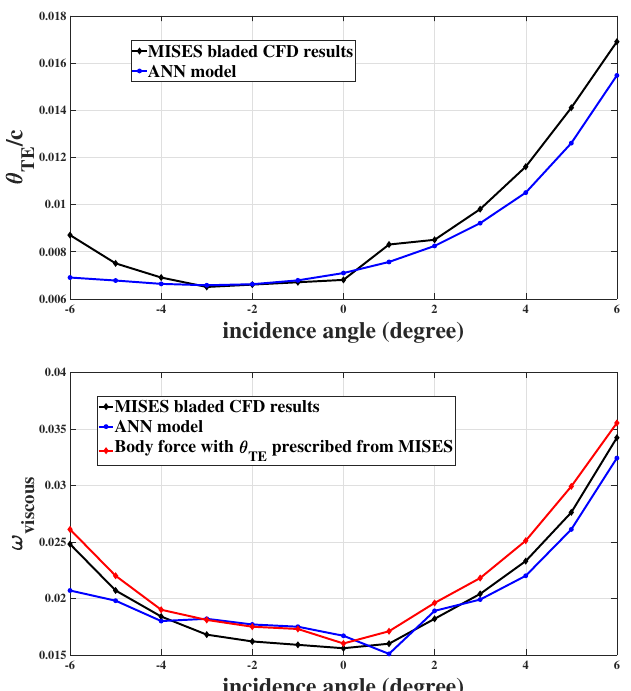
Figure 8. Comparison of trailing edge momentum thickness ( top ) and loss coefficient ( bottom ) from MISES and ANN model for cascade 2 ( σ = 1.2, M ∞ = 0.65, Re = 7 × 10 5